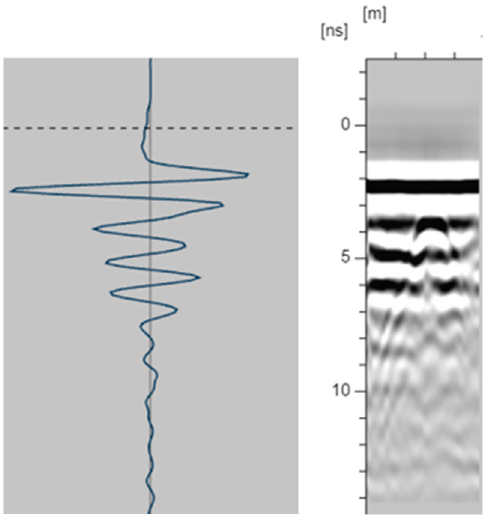
Figure 2. Schematic diagram of time zero calibration.